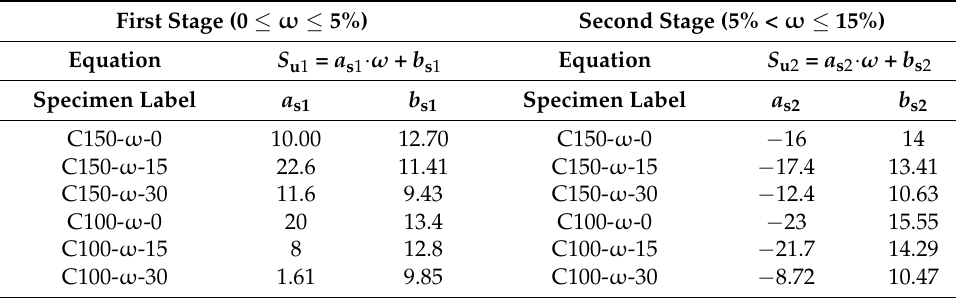
Table 5. The ultimate slip as a function of stirrup corrosion rate ω